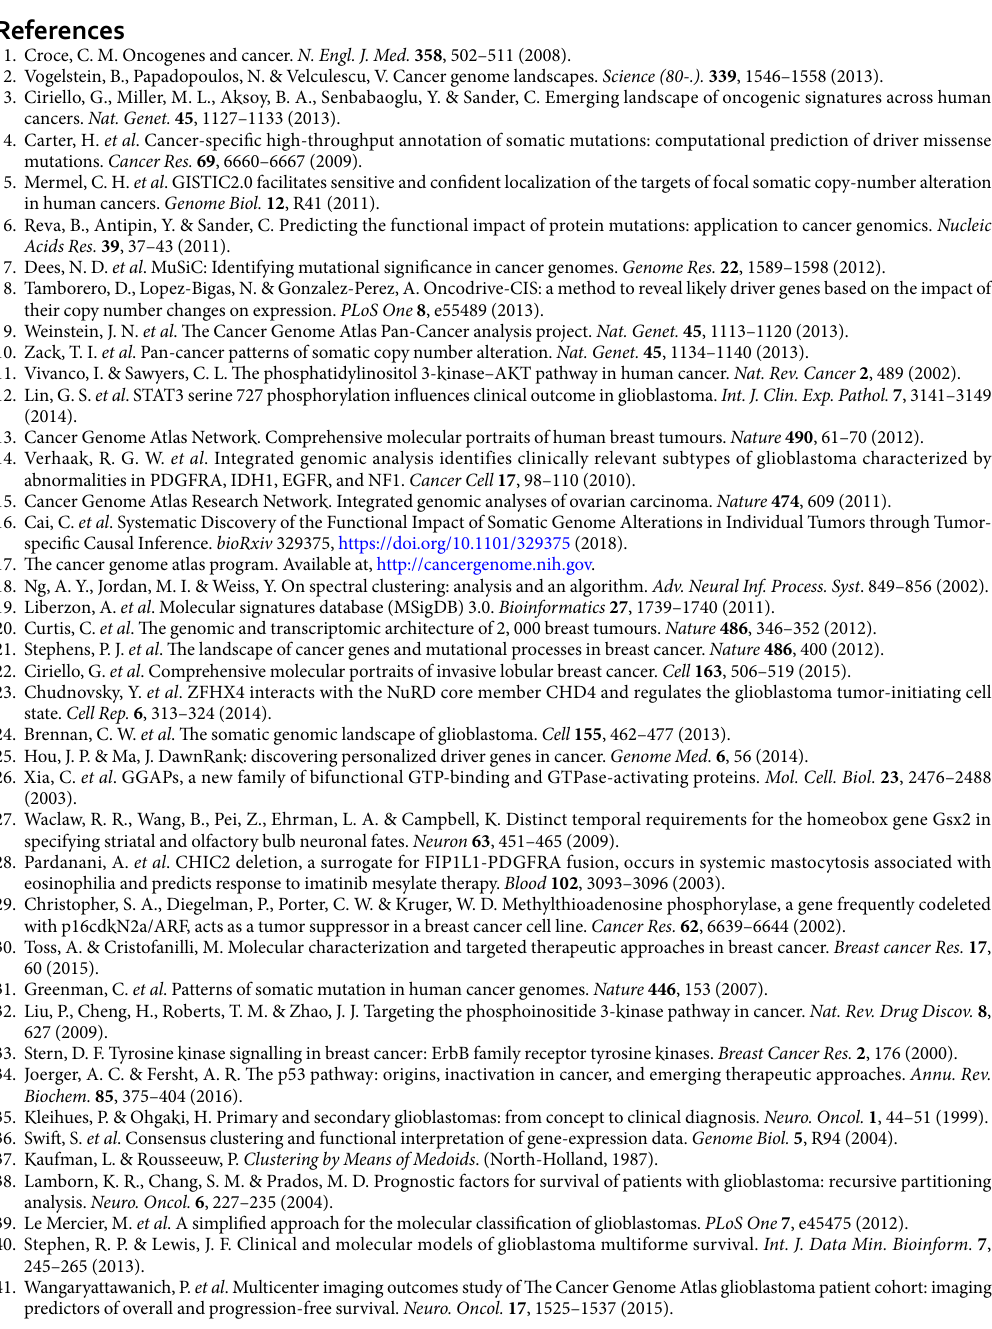
Figure processing. All multipart figures were prepared using Adobe Photoshop CS6 version 13.0. Contrast was adjusted for Figs 2 and 3, and the adjustment was applied equally across both entire